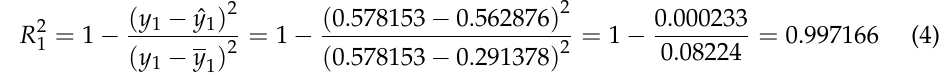
Table 1. Comparison of proposed models [authors’ own processing].